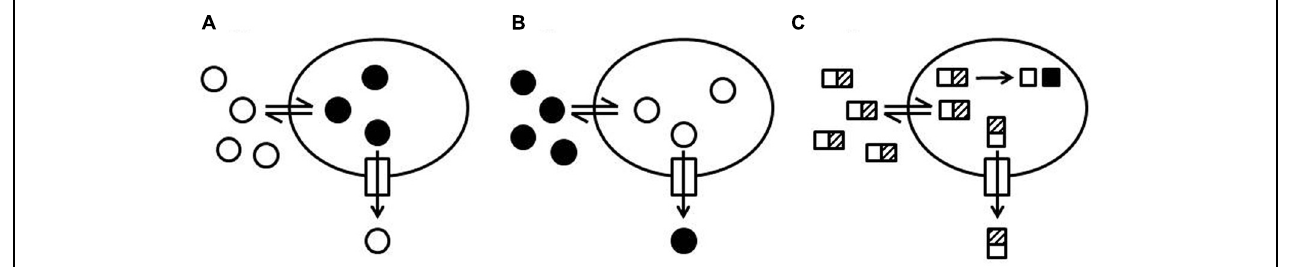
FIGURE 2 | Schematic representation of efflux assay formats. (A) Increase of fluorescence intensity upon internalization of a probe. A probe with low fluorescence intensity in the medium surrounding the cells (open circles) is taken up by cells (double arrow). The fluorescence intensity of the probe increases when the probe is internalized (black circles) and interacts with cellular structures such as DNA, proteins, or membranes. Efflux of the probe (arrow through the box to the outside) causes a decrease of the total fluorescence and efflux inhibition causes an increase of the total fluorescence. (B) Quenching of fluorescence intensity upon internalization of a probe. A fluorescent probe (black circles) is added to the medium surrounding the cells. The fluorescence intensity of the probe decreases when the probe is taken up by the cells